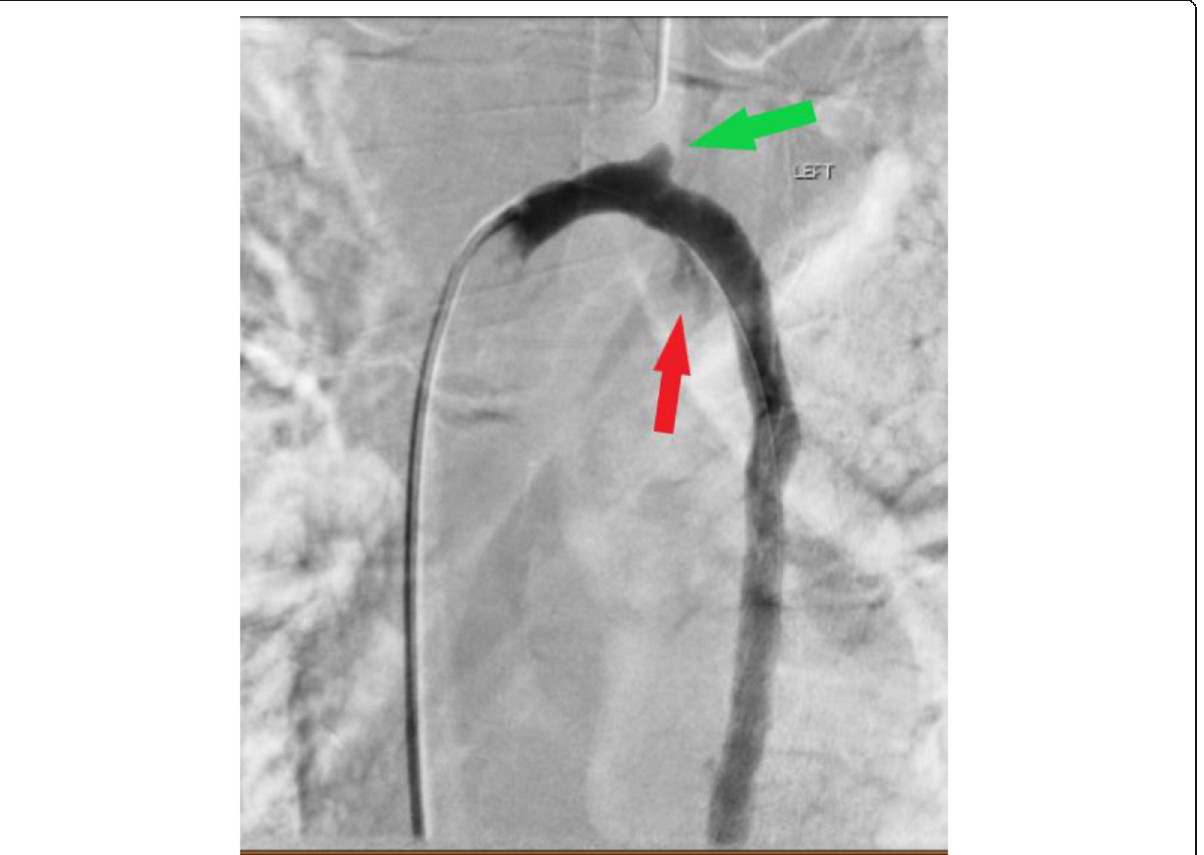
Fig. 2 DSA in the LAO projection highlights pseudoaneurysm of the superior arch (green arrow) and extravasation from the inferior arch (red arrow)